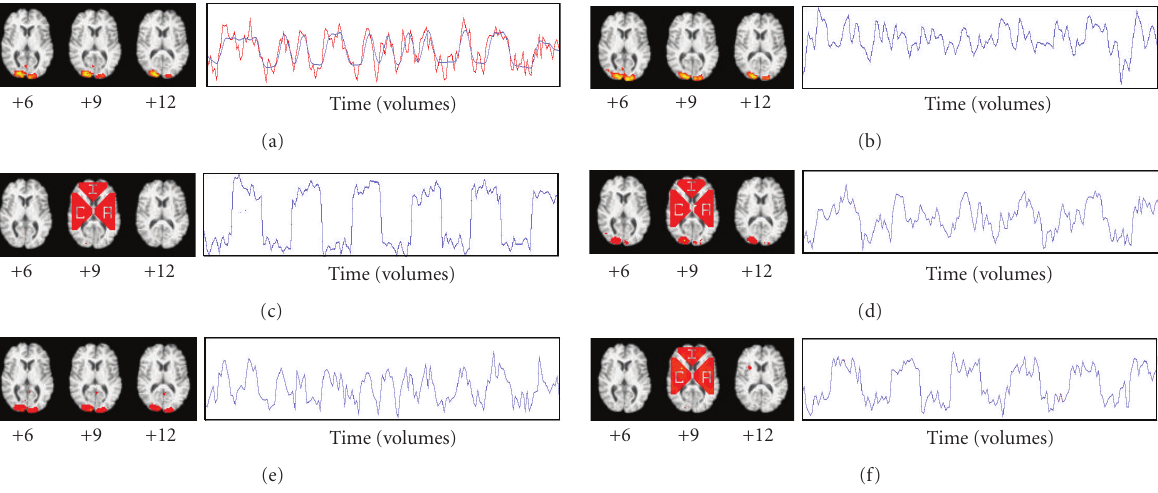
Figure 2: Spatial maps and time courses derived from task-related GLM, ICA, seed-based approach, and hybrid ICA-seed-based approach. Numbers below axial brain slices indicate z -coordinate (MNI). Blue lines: time courses from linear model. Red lines: fMRI data deviating from model, at voxel with best fit to model. (a) Task-related GLM. (b) Natural IC. (c) Artificial IC. (d) Seed-based FC. (e) Hybrid FC, seed from natural IC. (f) Hybrid FC, seed from artificial IC. The bright yellow dots (d–f) show seed locations.